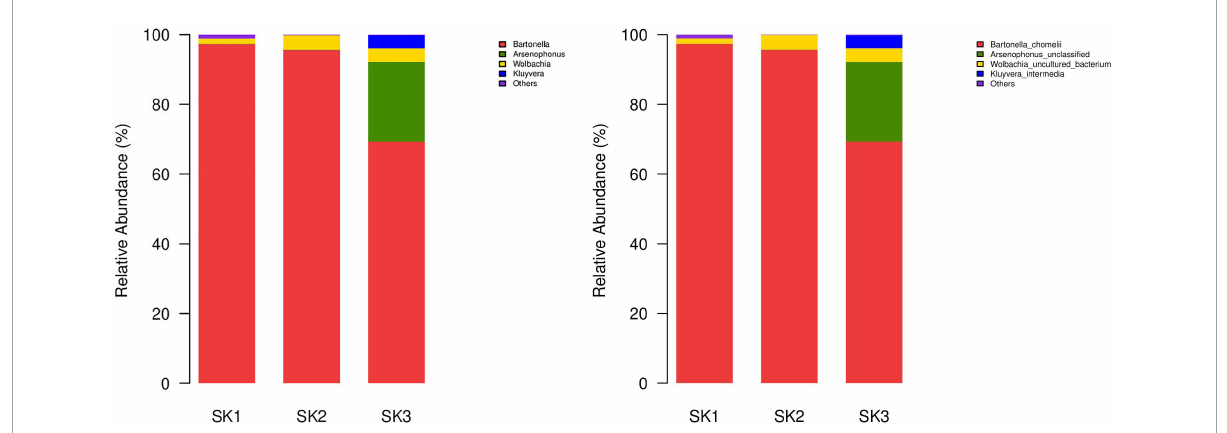
FIGURE3 Microbial community bar plot of bacteria from three Melophagus ovinus samples (Left: Bacterial genus; Right: Bacterial